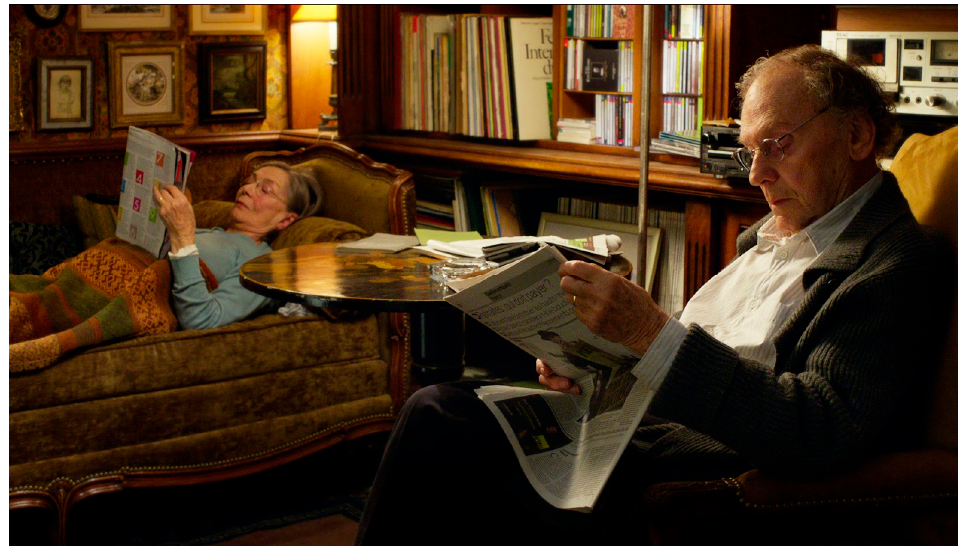
Figure 1. Georges and Anne’s simple life together.